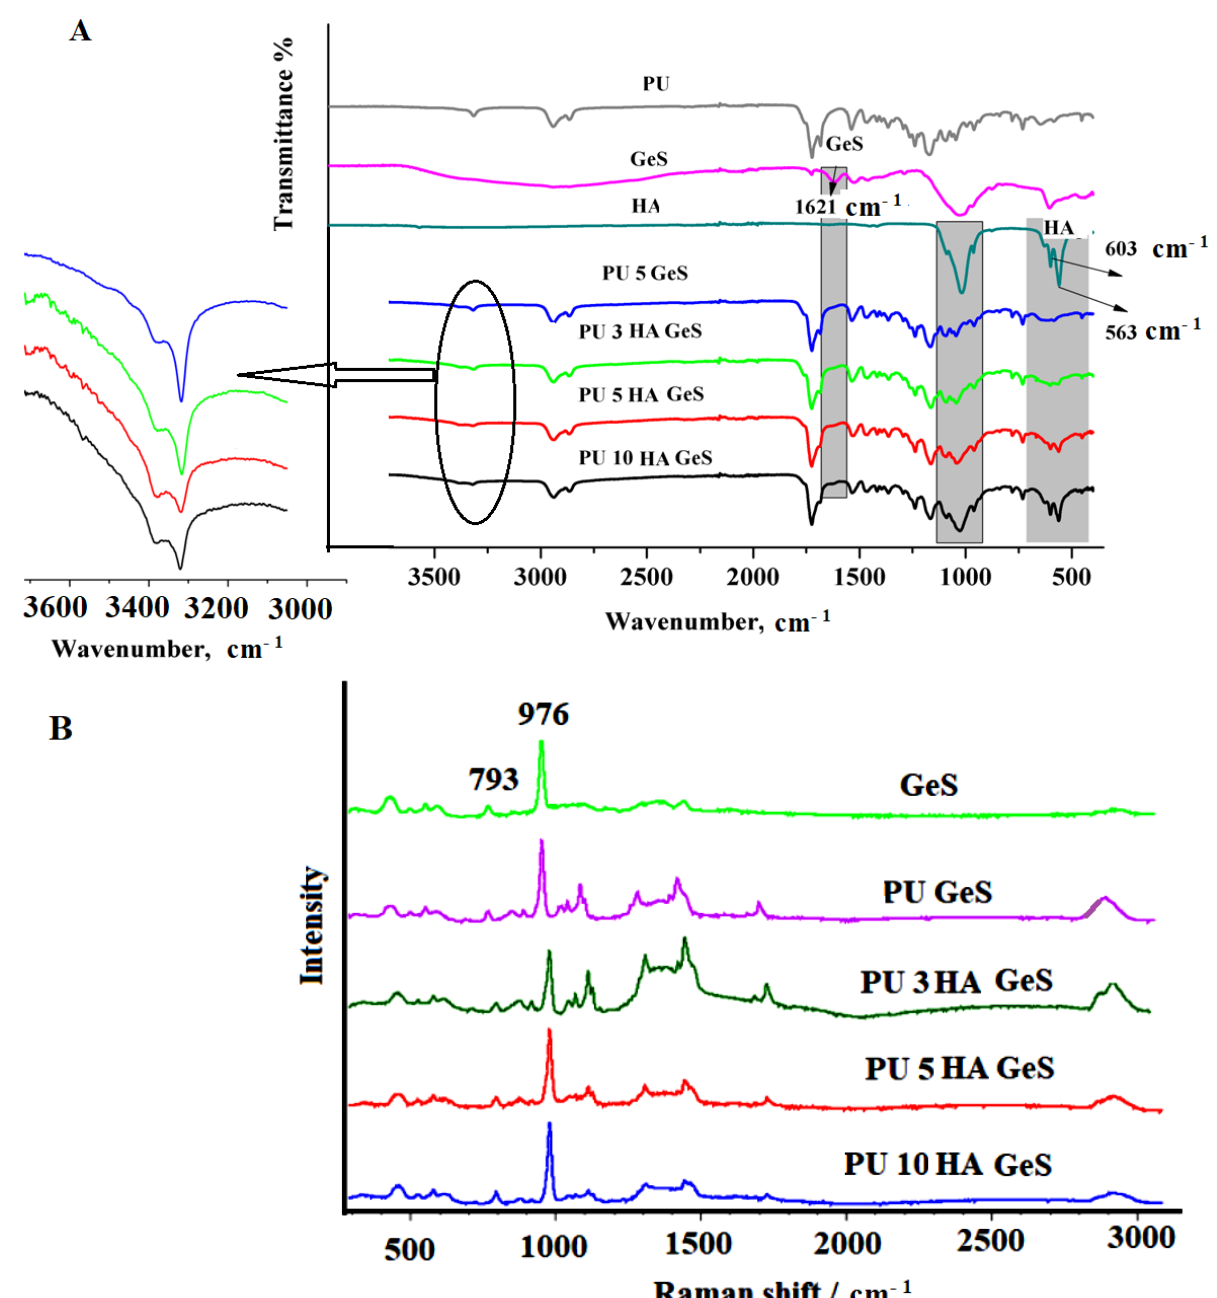
Figure 1. ( A ) SEM BSE images of composite surfaces with various contents of HA and 5 wt% of GeS. ( B ) EDS analysis showing distribution of S, Ca, P within PU matrix. Violet color—sulfur distribution originating from GeS, green—phosphor distribution from HA, yellow—calcium distribution that originates from HA.